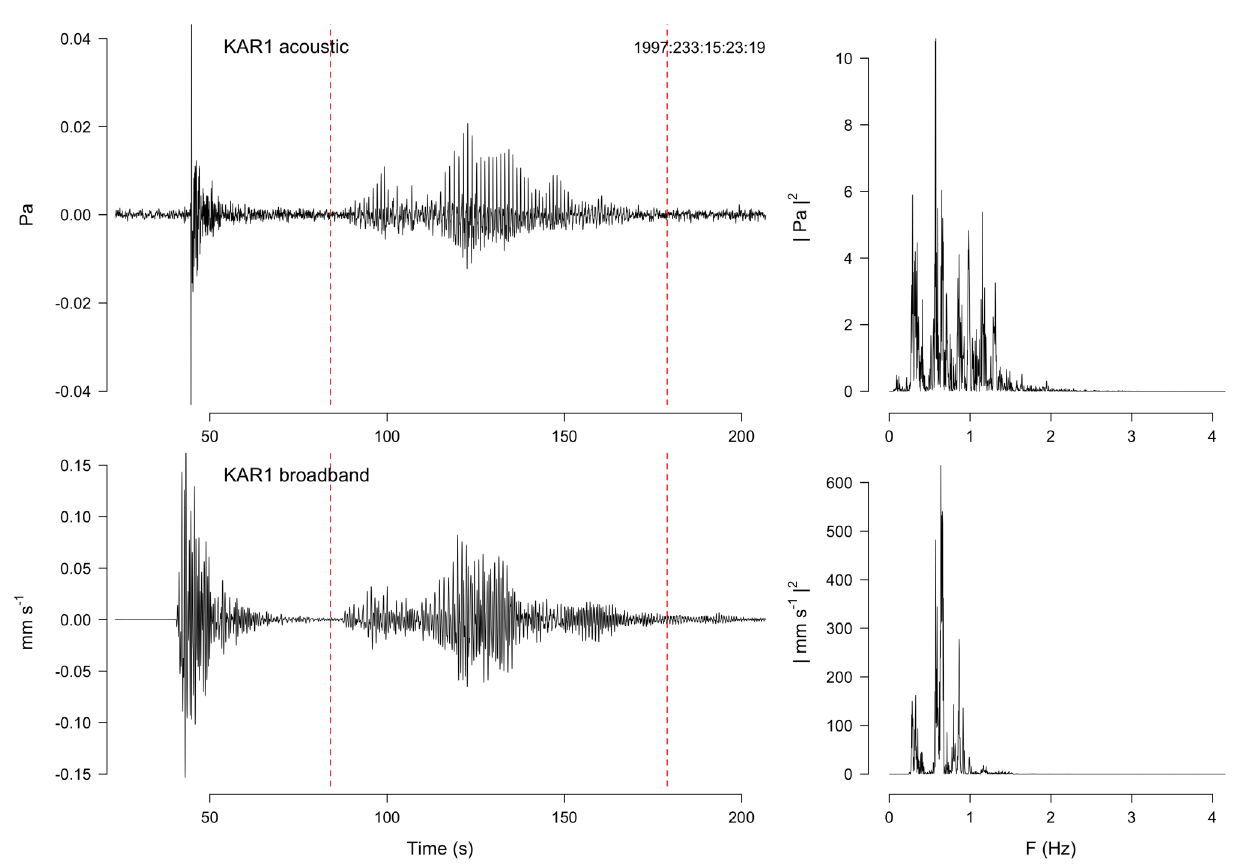
Figure 1: Example of a characteristic chugging sequence recorded at Karymsky volcano in August, 1997. The top panel shows the infrasound signal and its Fourier spectrum for the chugging portion of the waveform only (bounded by vertical red lines). The bottom panel shows the seismic data recorded during the same